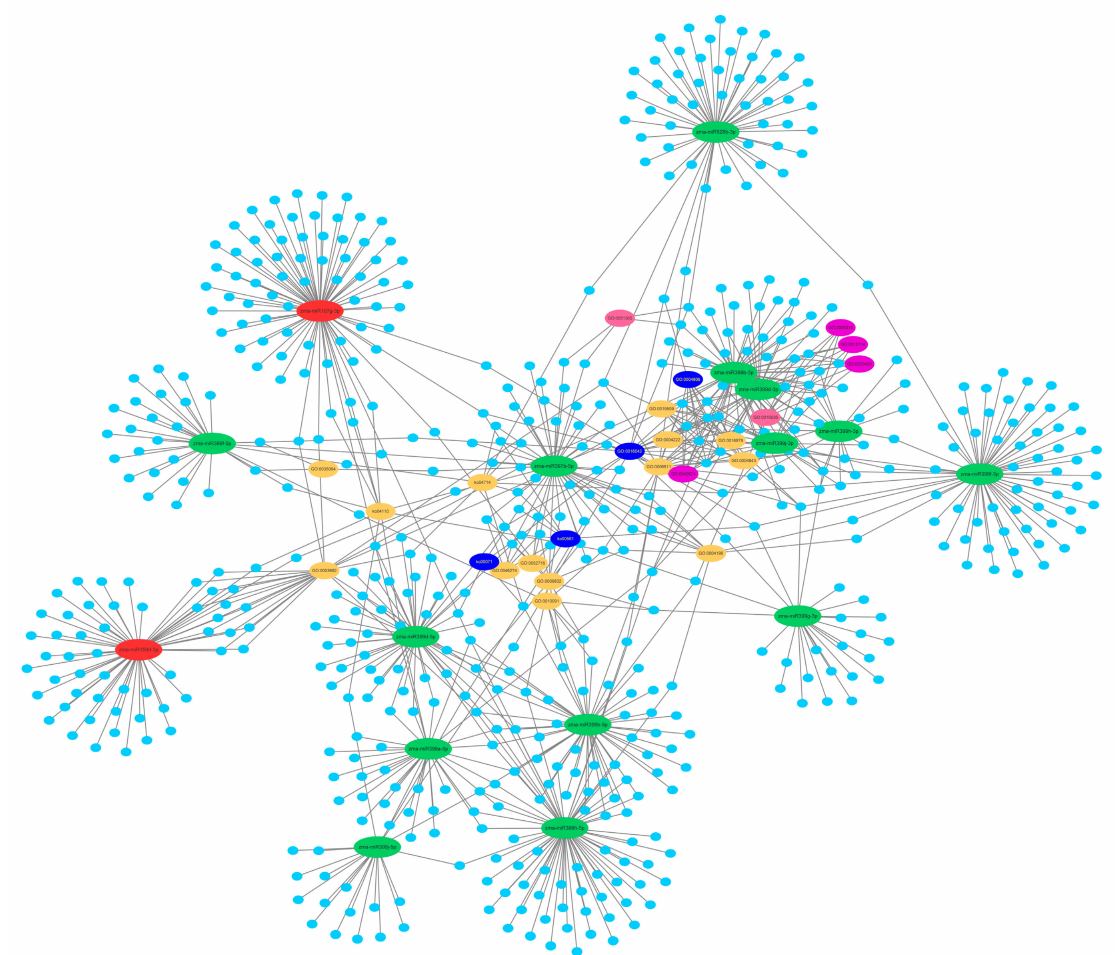
Figure 7. The potential regulating network of arbuscular mycorrhiza (AM)-responsive miRNAs in maize root. Red ovals represent up-regulated miRNAs; green ovals represent down-regulated miRNAs; blue ovals represent lip metabolism related pathways; purple ovals represent phosphate uptake related pathways; pink ovals represent starve responsive related pathways; yellow ovals represent the rest enriched pathways; and cyan circles represent the miRNA target